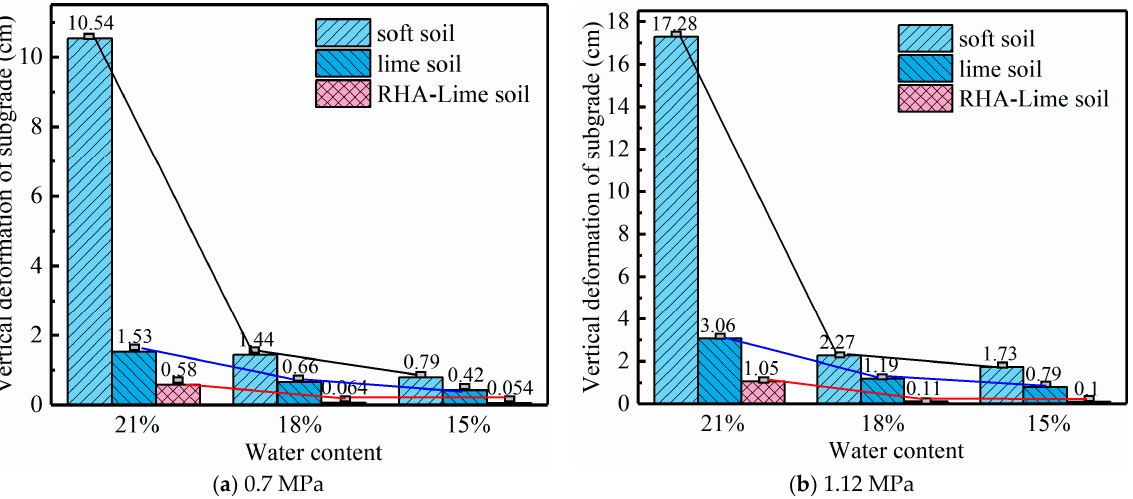
Figure 16. The creep deformation of the subgrade in the vertical direction.